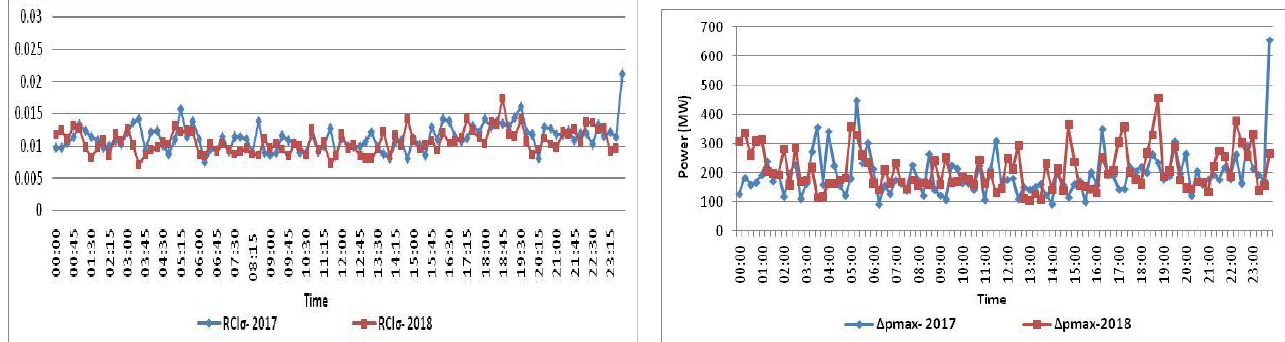
Figure 16. Comparison between maximum values of upward power ramps in 15 min interval at each observation time t for the years 2017 and 2018.